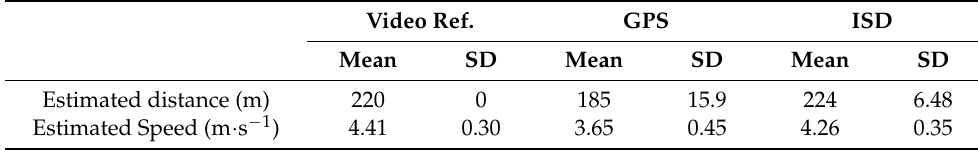
Table 1. Descriptive measures for distance and speed.